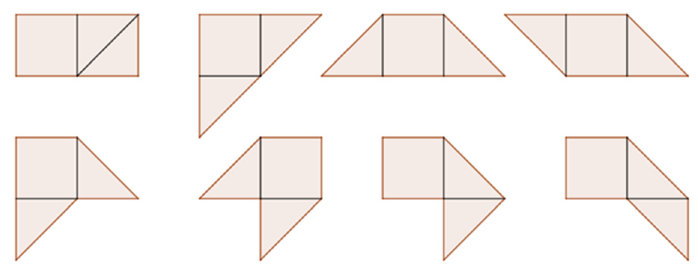
Figure 11. Result shapes of Task 2.